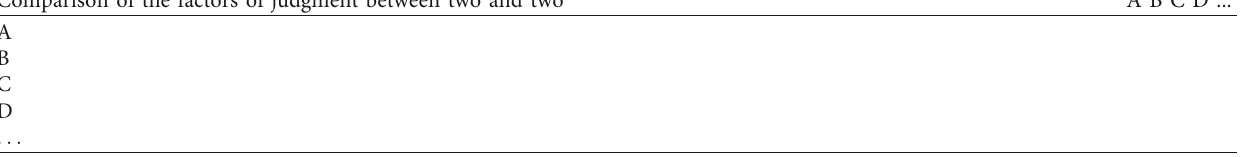
Table 1: Comparison matrix.